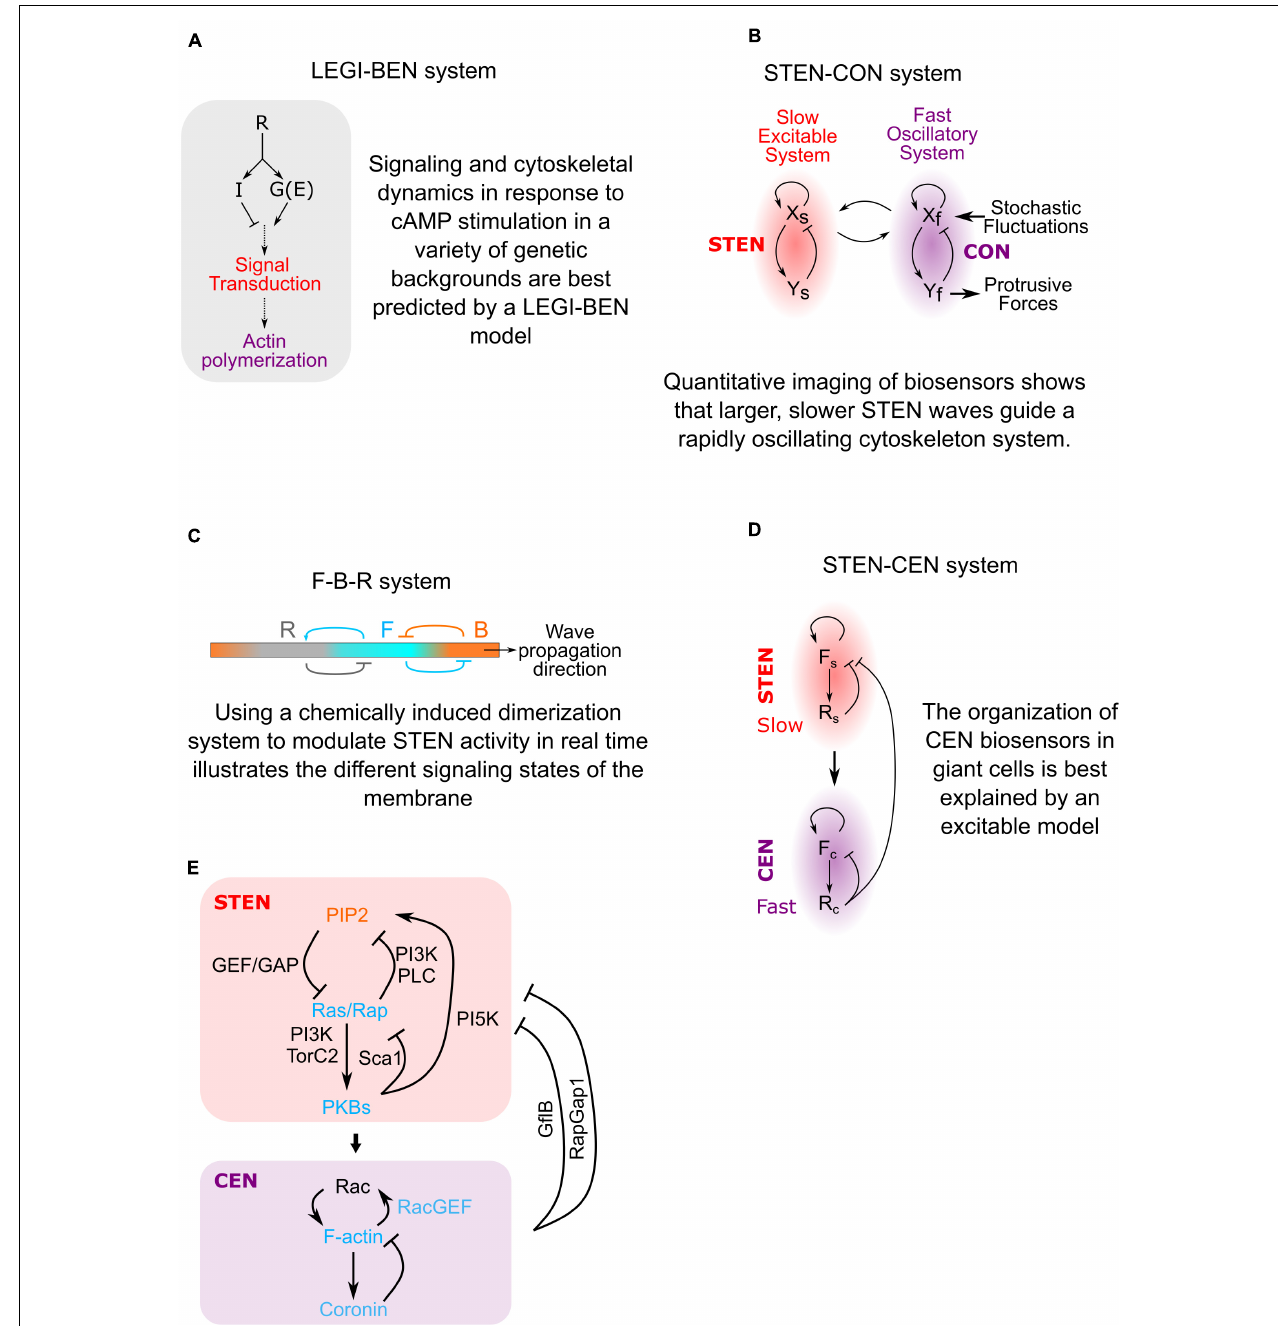
FIGURE 2 | The evolution of directed migration models. (A) By monitoring how signaling and cytoskeletal dynamics change during cAMP stimulation in different genetic backgrounds we were able to build a model of gradient-sensing. The cell has two responses to Receptor (R) activation: locally, heterotrimeric G-proteins (G) create an Excitor (E) of signal transduction excitation. Globally, the cell produces an Inhibitor (I) which lowers the probability of excitation. This Local Excitation and Global Inhibition (LEGI) of a Biased Excitable Network (BEN) explains how cells moves in the correct direction even in shallow gradients. (B) Imaging of signaling biosensors independent of cytoskeletal proteins revealed excitable behavior. In the absence of signaling activity, cytoskeletal biosensors rapidly oscillate at small membrane patches. The Cytoskeletal Oscillatory Network (CON) is only able to form large, sustained protrusions when driven by the Signal Transduction Excitable Network (STEN). (C) Using data from chemically induced dimerization perturbations, a model of how cell front and back activities are segregated was created. The membrane sits in a resting state equivalent to the cell back state (B). STEN excitation converts a patch of the membrane to a front state (F). This F state inhibits the B state but also gradually creates its own inhibitor that converts F-state membrane to a refractory state (R). This explains how activities like Ras activation and actin polymerization propagates across cell membranes but is transient at any single location. (D) Biosensor dynamics show that the cytoskeletal network also has excitable properties. The Cytoskeletal Excitable Network (CEN) is coupled to the STEN but works on a faster timescale, explaining the structure of STEN-CEN waves on the bottom membrane of giant cells. (E) Diagram of the STEN-CEN network sketched out in panel (D) with specific molecules added.